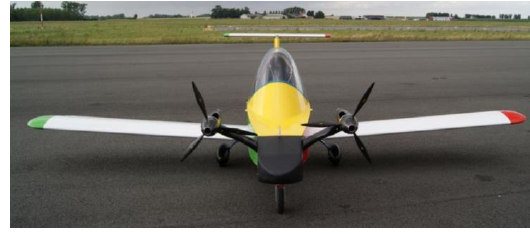
Fig. 9. MC-15 Cri-Cri airplane